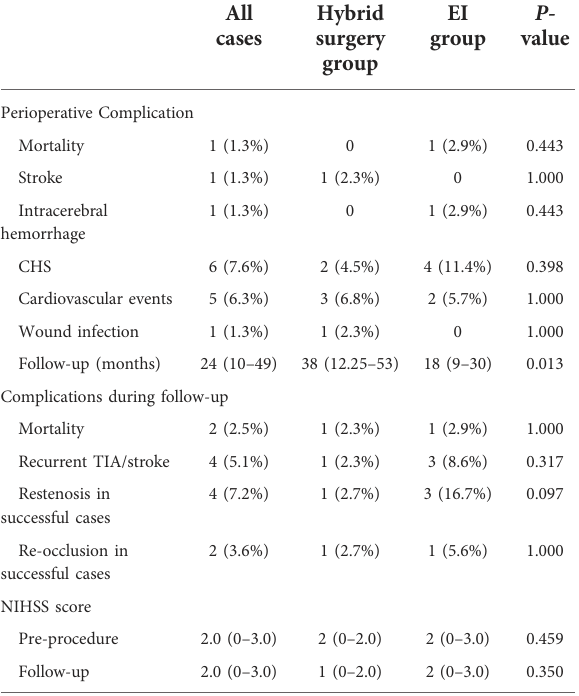
TABLE 3 Incidence of perioperative complications, complications during follow-up and NIHSS